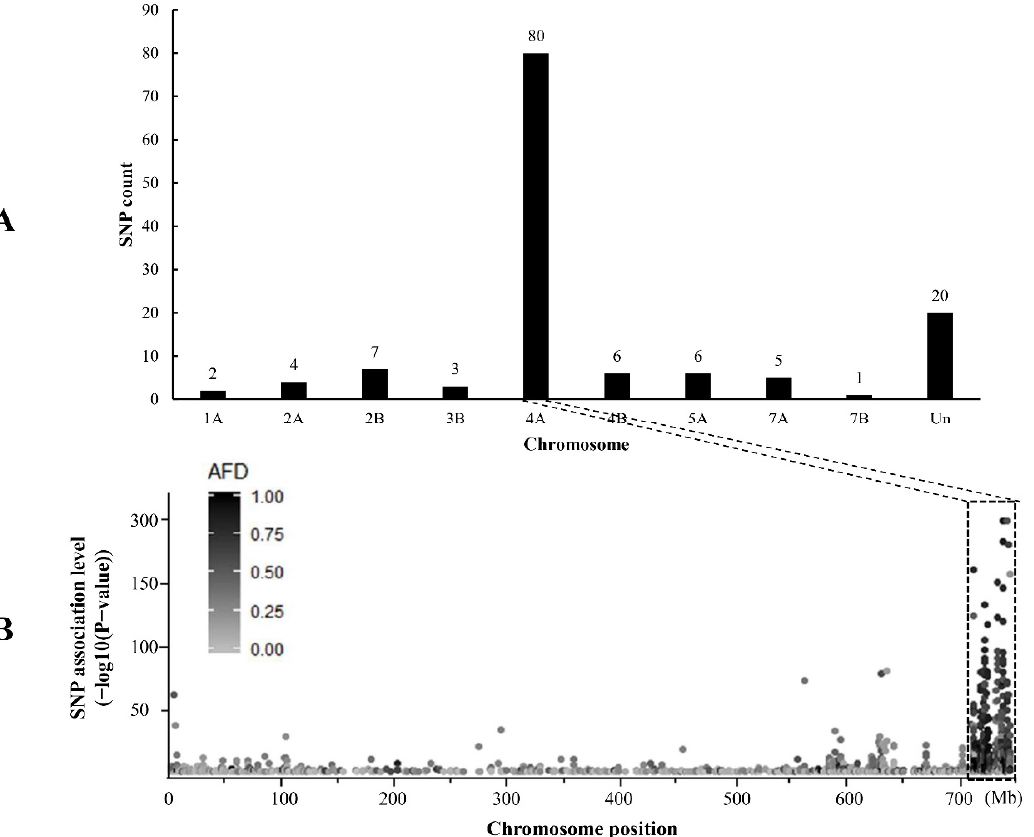
Figure 2. Number of polymorphic single nucleotide polymorphism (SNP) distributed on different wheat chromosomes ( A ) and distribution of SNP variants on chromosome 4A ( B ).